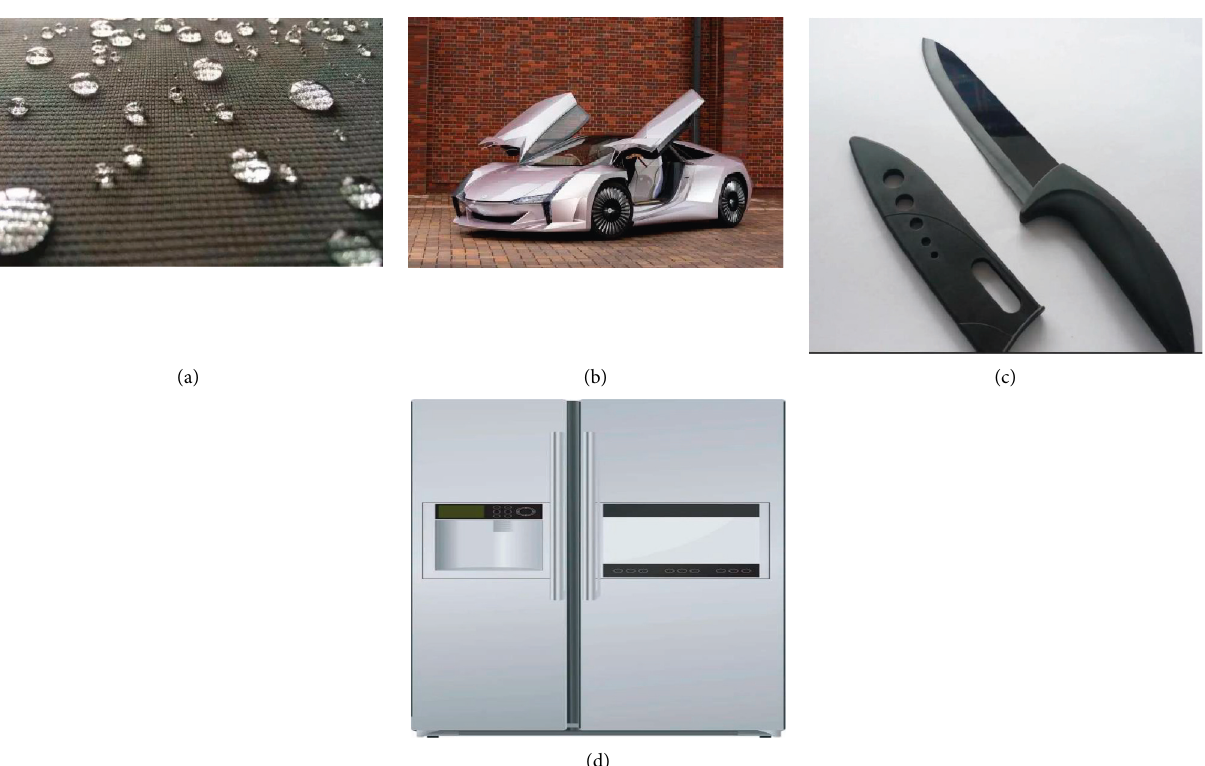
Figure 3: Applied products of nanomaterials. (a) Nano waterproof material, (b) nano titanium dioxide car paint, (c) nano-ceramic cutting tool, and (d) nano-refrigerator coating.